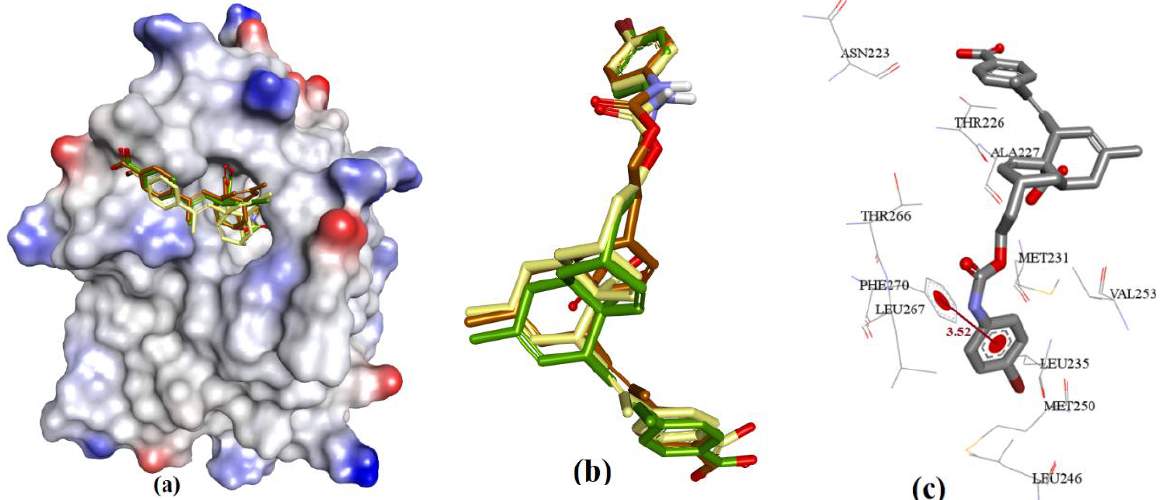
Figure 22. ( a ) The ionized solvent-exposed surface mapping of hMcl-1 along with the docked poses of 8a from MOE (in brown), AutoDock (in green), and VlifeDock (in yellow) show their fitting to the cavity. ( b ) Similar-pose ensemble clustering of all three poses was attained from the three different docking methods. ( c ) Binding mode of 8a .